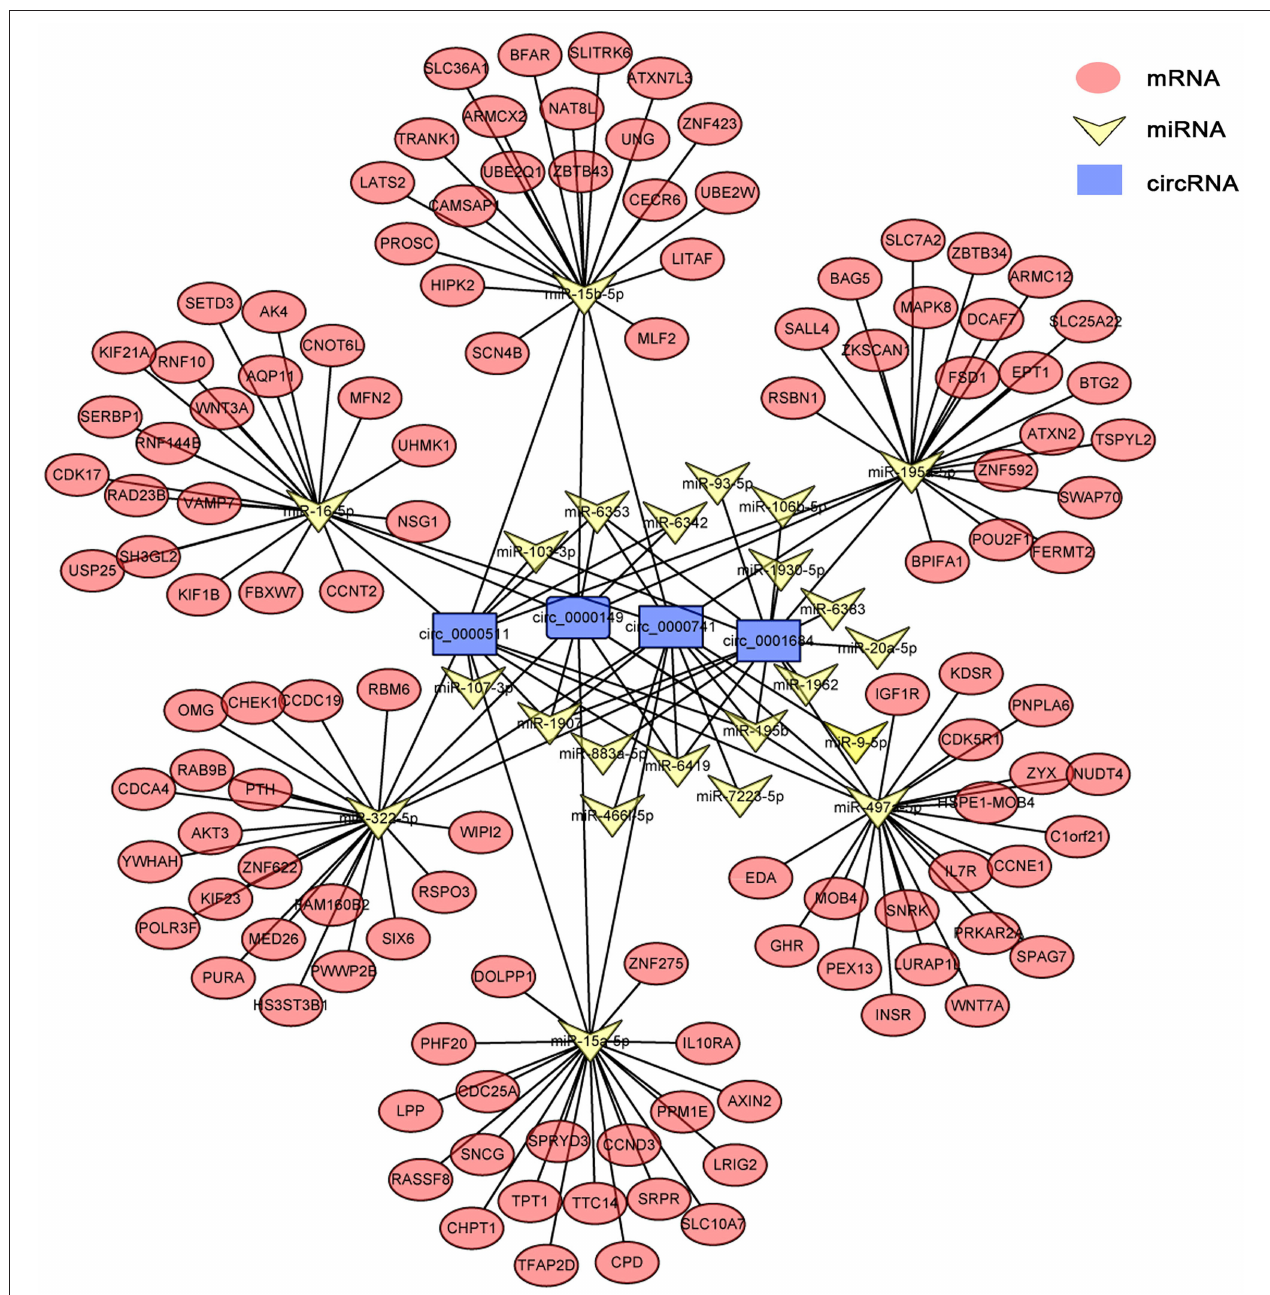
FIGURE 5 | circRNA–miRNA–mRNA network diagram of Kupffer cells. Blue, yellow, and red nodes correspond to circRNAs, miRNAs, and mRNAs, respectively. The black lines correspond to the interactions between RNAs.